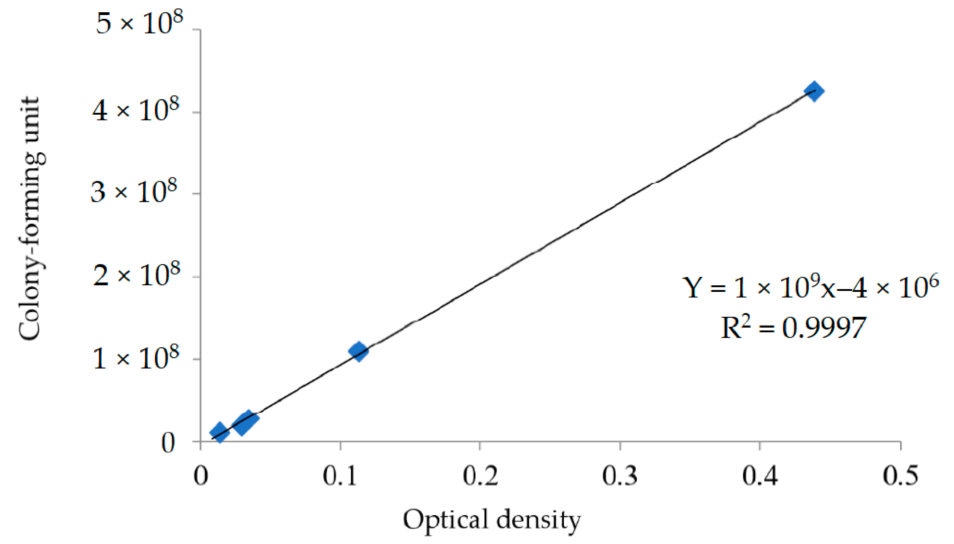
Figure 3. The calibration curve of OD S and bacterial concentrations by the spreading plate method in the antibacterial test against E. coli . Table 2. The antibacterial activity of UV films with different Zn(HEEP) 2 additions against E. coli in the dynamic shaking culture